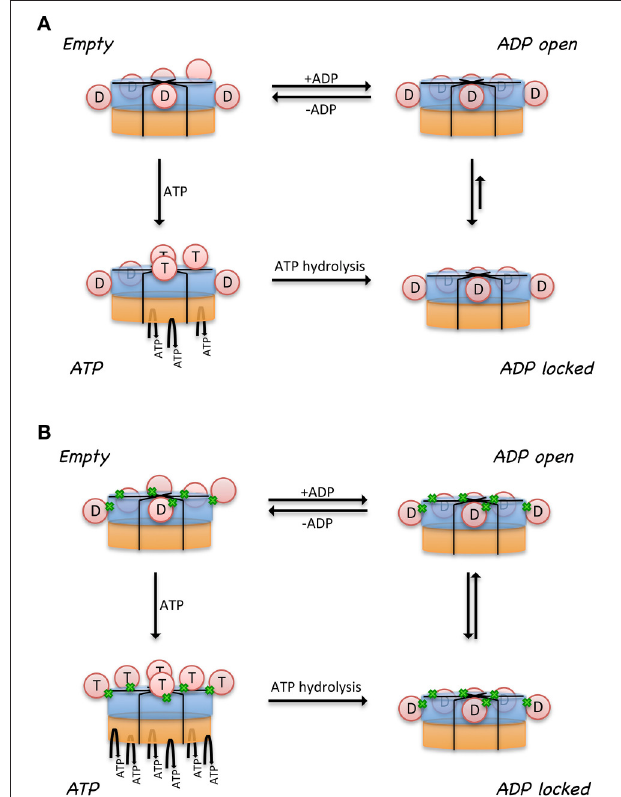
FIGURE 3 | Model proposed for the relationship between control of N domain conformation and ATPase activity in p97. Cartoon representation of a hexameric p97 shows the D1 domains in blue, D2 domains in orange, and the N domains in pink circle. N domains that are labeled with the letter “D” are in the Down-conformation and their corresponding D1 domains are occupied by ADP. N domains that are labeled with the letter “T” are in the Up-conformation and their corresponding D1 domains are occupied with ATP. Only those subunits that have their D1 domains occupied by ATP are capable of hydrolyzing ATP in their D2 domains. The conformation of the N domains is not determined when their corresponding D1 domains are empty (No label in the N domain). Proposed nucleotide binding and hydrolysis cycle for (A) the wild-type p97 and for (B) mutant p97. Mutations are represented by the green dots at the interface between N and D1 domains. Empty state indicates a state in the absence of added ATP or ADP. The ATP state is the presence of added ATP. The ADP-locked state refers to a subset of subunits where ADP in the D1 domain is very tightly bound, whereas the ADP-open state refers to a subset of subunits where ADP molecules in the D1 domains are able to exchange nucleotides with those in solution. The ADP-locked and ADP-open states are in equilibrium in